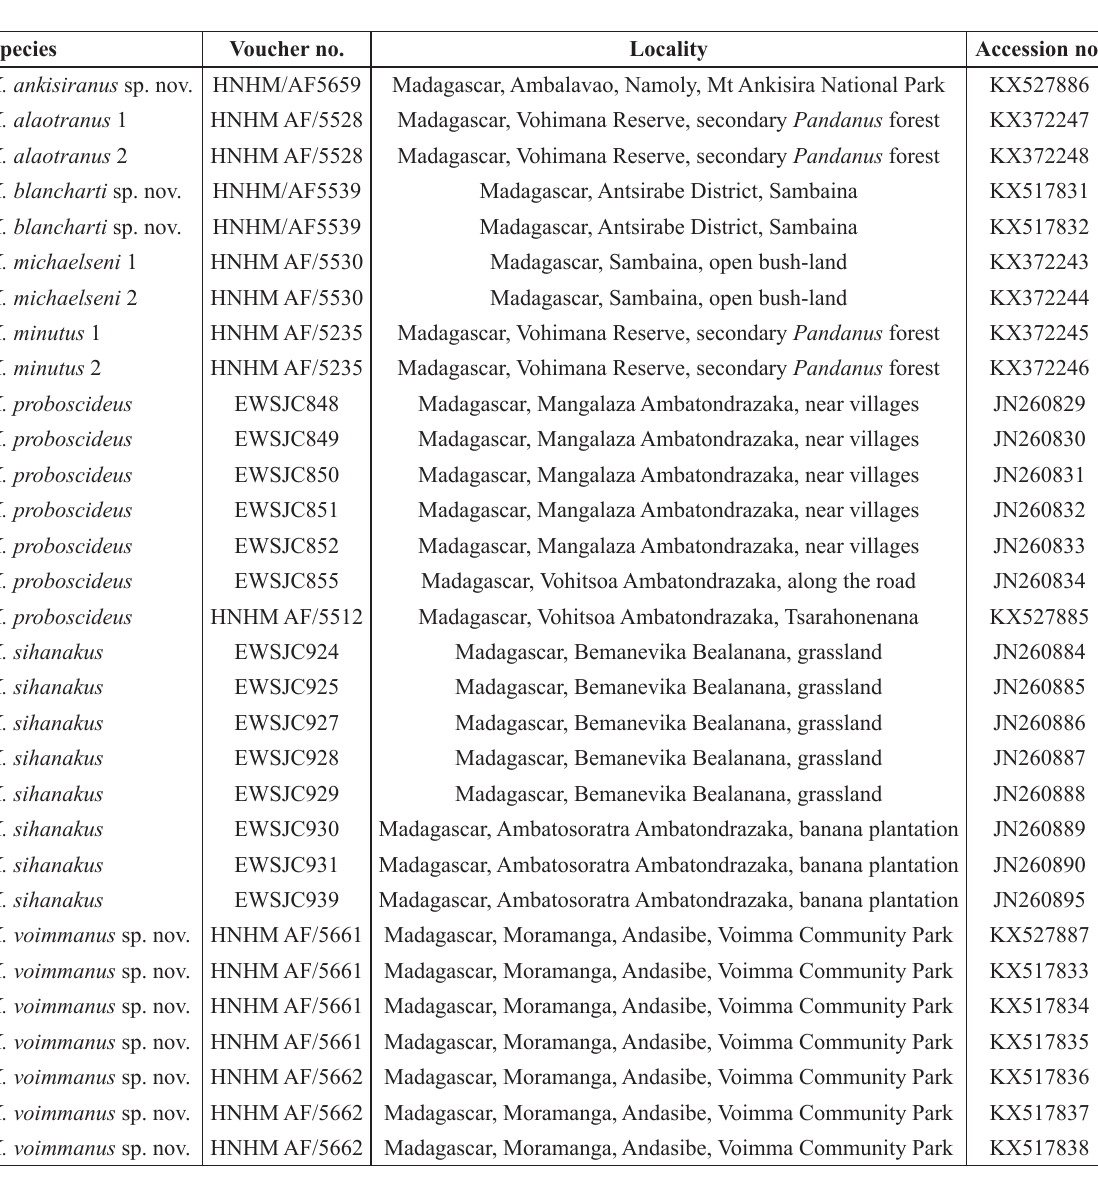
Table 1. Localities and COI Genbank accession numbers of the specimens of Kynotus analysed (EWSJC samples were obtained by Sam